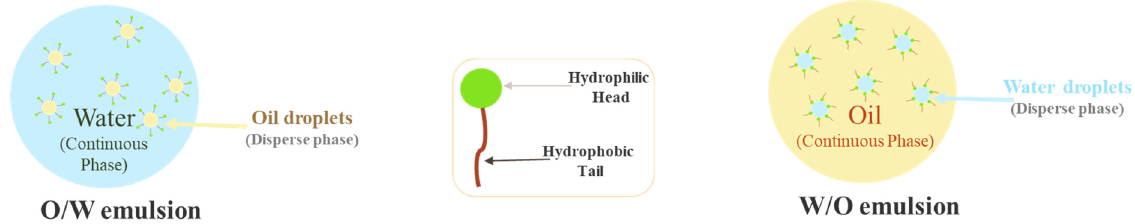
Figure 1. Oil in water (O/W) emulsion, and water in oil (W/O) emulsion.